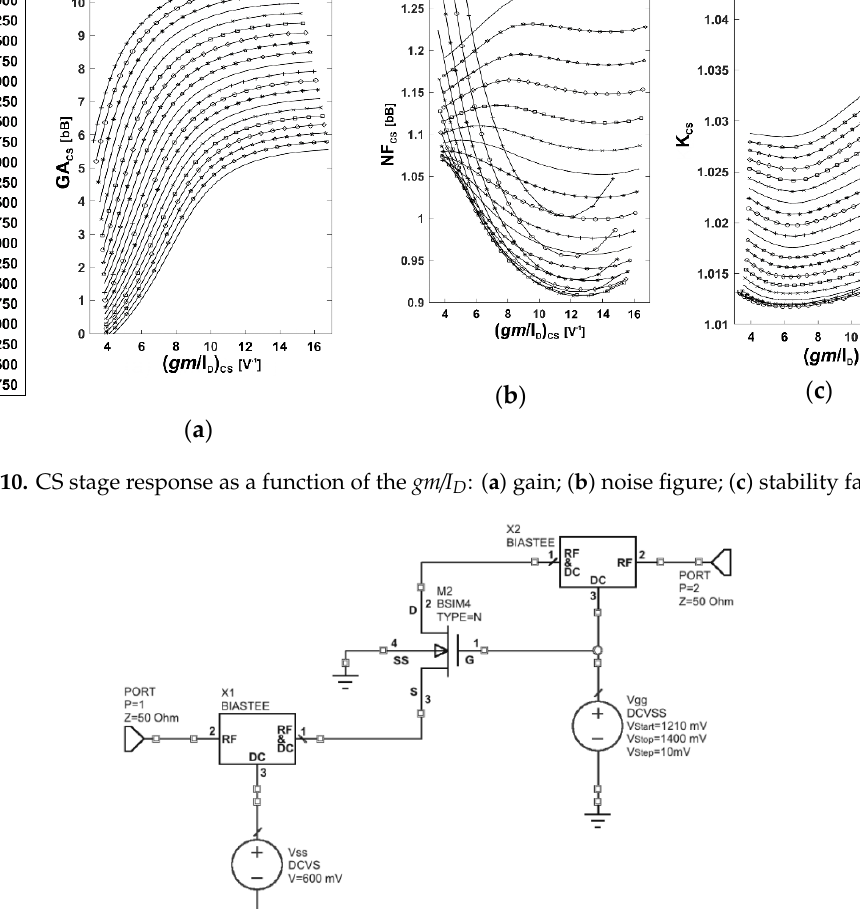
Figure 10. CS stage response as a function of the gm/I D : ( a ) gain; ( b ) noise figure; ( c ) stability factor K .